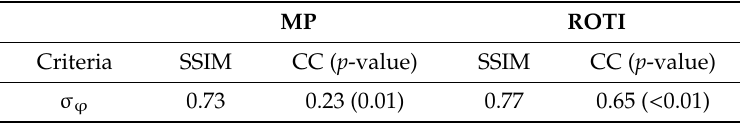
Table 12. SSIM and CC between the maps shown in Figure 13a.